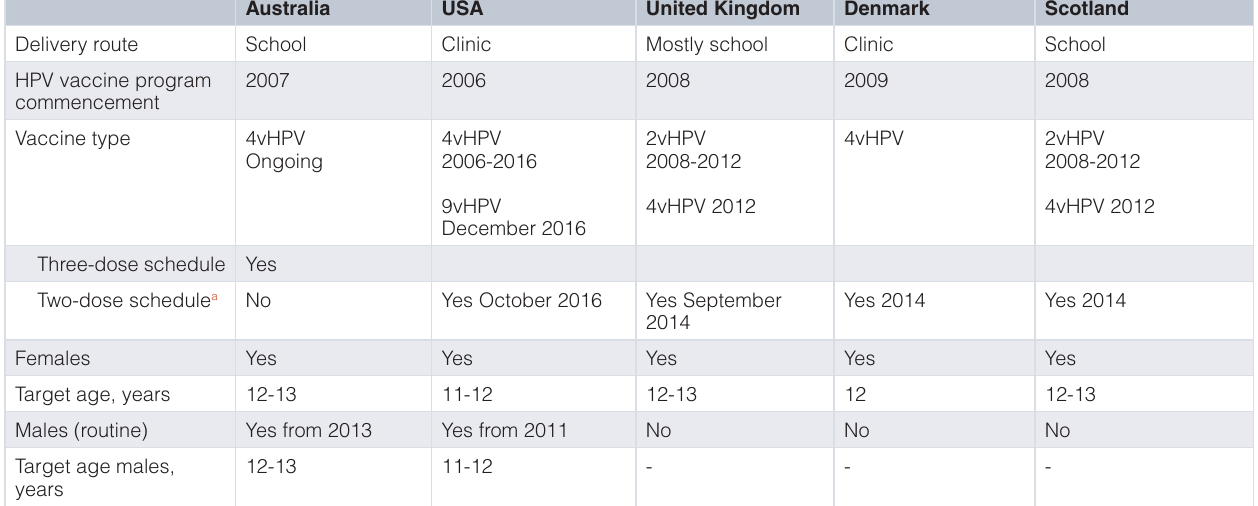
Table 1. Summary of human papillomavirus vaccination programs, outcomes and cervical screening